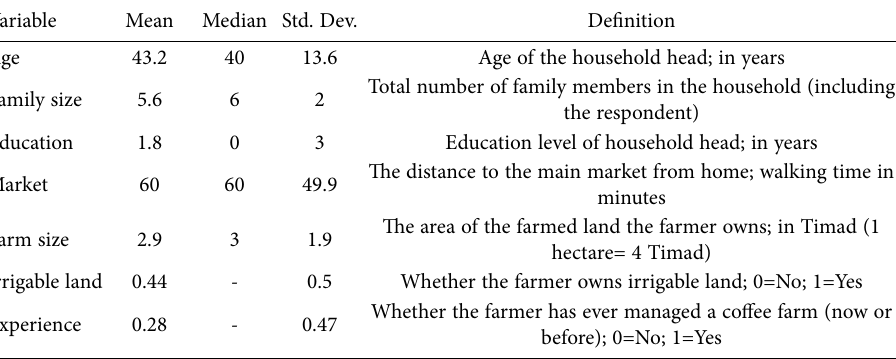
Table 3. Description of sociodemographic variables used to explain the variations in farmers’ prefer- ences for the selected coffee